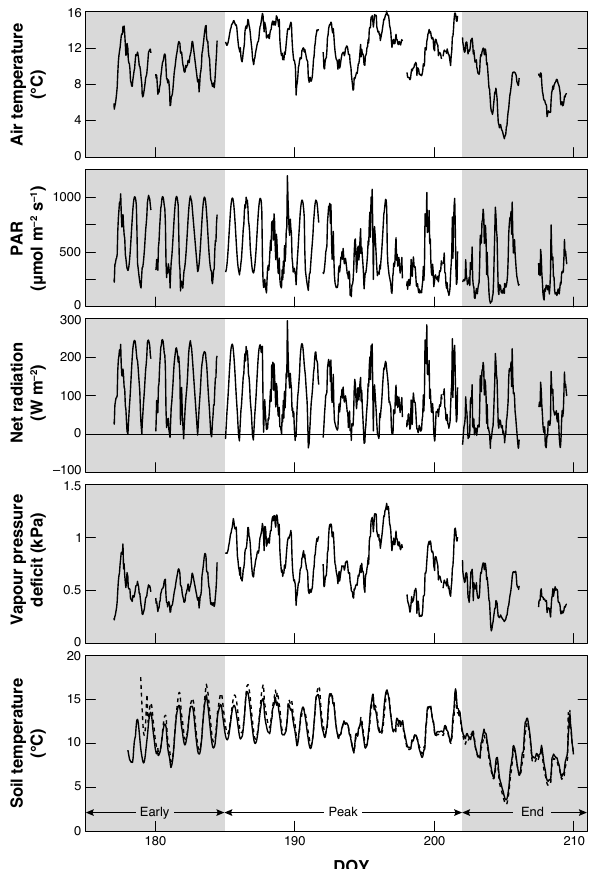
Figure 3. Meteorological conditions during the 2014 growing sea- son at T2. Height of all instrumentation on the tower was 1m above the canopy. Soil temperatures were measured at a depth of − 5cm, and mean temperature is shown for the disturbance (dashed line; n = 7) and undisturbed tundra (solid line; n = 14). DOY: day of the year.